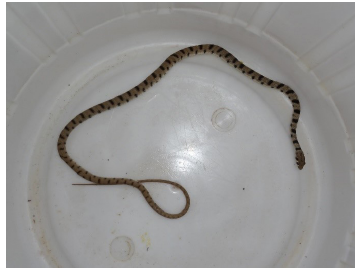
Figure 3. Platyceps karelini spotted dorsal